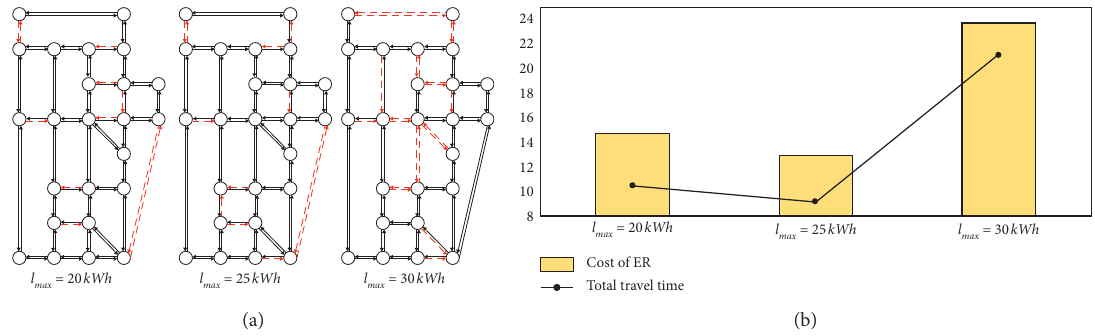
Figure 6: Comparison of the ER with different battery sizes. (a) Location designs. (b) Total travel time and cost of the